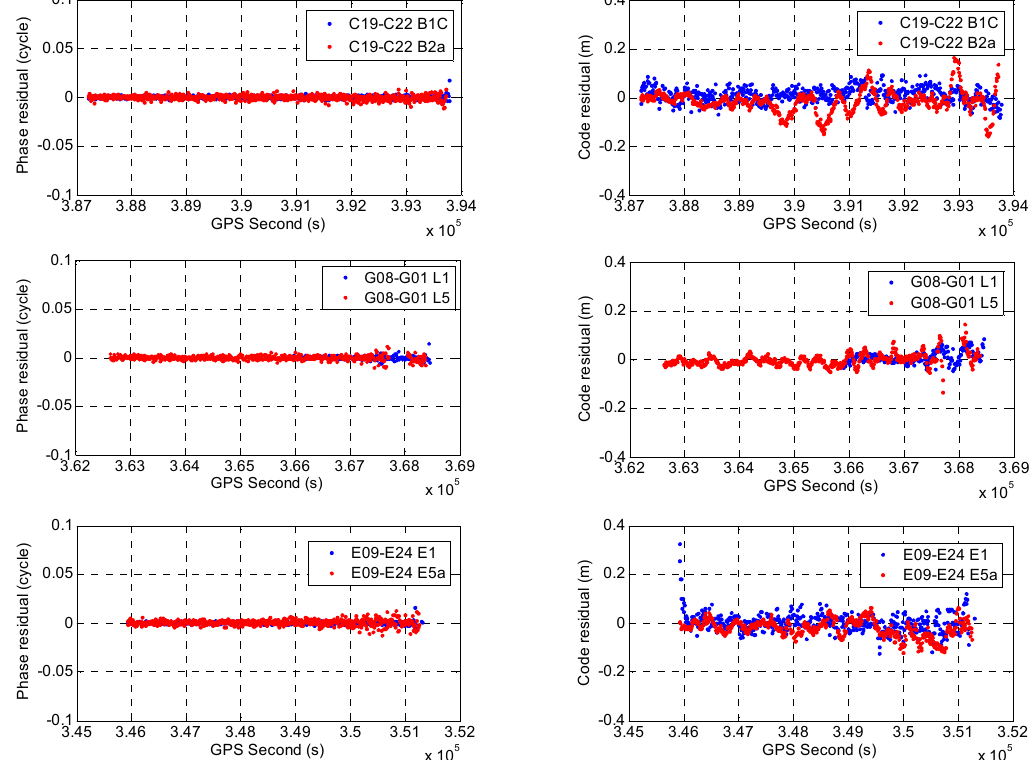
Figure 6. Zero-baseline double-differenced carrier phase and code residuals for representative satellite pairs of C19-C22 ( top panels ), G08-G01 ( middle panels ), and E09-E24 ( bottom panels ).